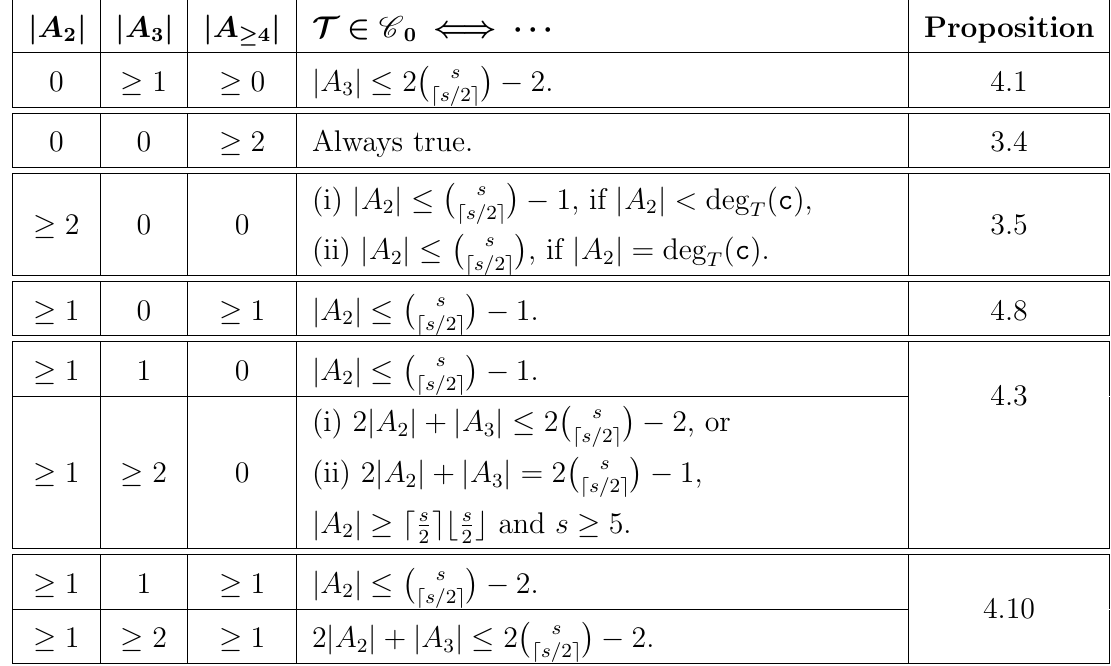
( s , s , . . . , s ), where s ≥ 3 is 4 1 2 n